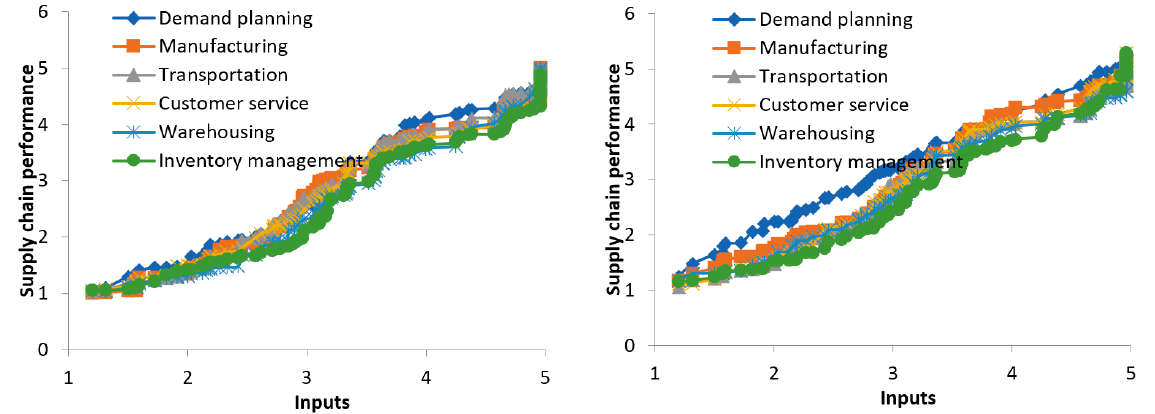
Figure 4. The relationships between demand planning, manufacturing, transportation, customer service, warehousing, inventory management, supply chain performance, and company performance.